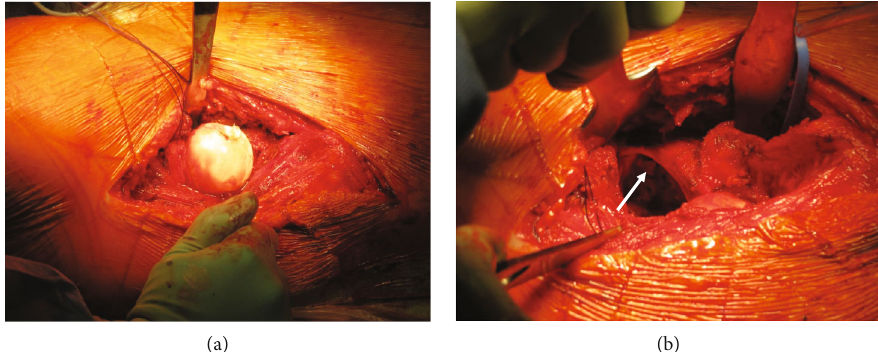
Figure 4: Intraoperative view of the anteriorly dislocated femoral head through the Smith-Petersen approach (a) and the acetabular cavity (b) after femoral head dislocation, demonstrating the integrity of the labrum (arrow).